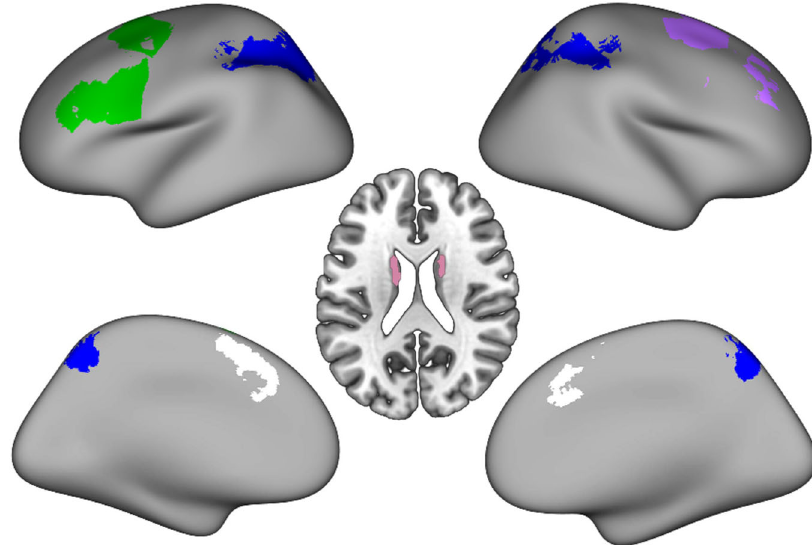
Fig. 5 Regions of interest. Five task-based regions of interest (left lateral prefrontal cortex [LPFC], green; right LPFC, purple; medial PFC, white; bilateral parietal cortex, blue; striatum, pink) derived from the whole-brain analysis of the 2-back >1-back contrast from the pre-training scan at a threshold of z = 4.0. Axial slice is shown at z =